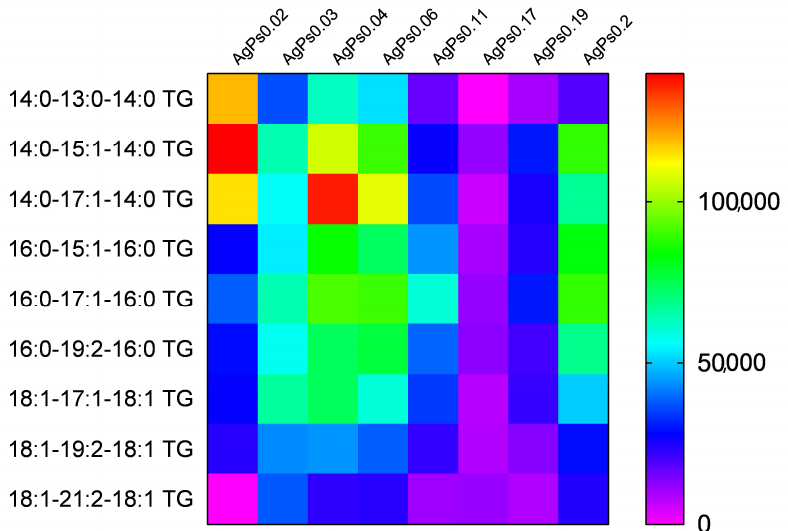
Figure 6. LDI-MS performance of LDI-MS plates with various masses of silver for analysis of standard mixture of triacylglycerols.